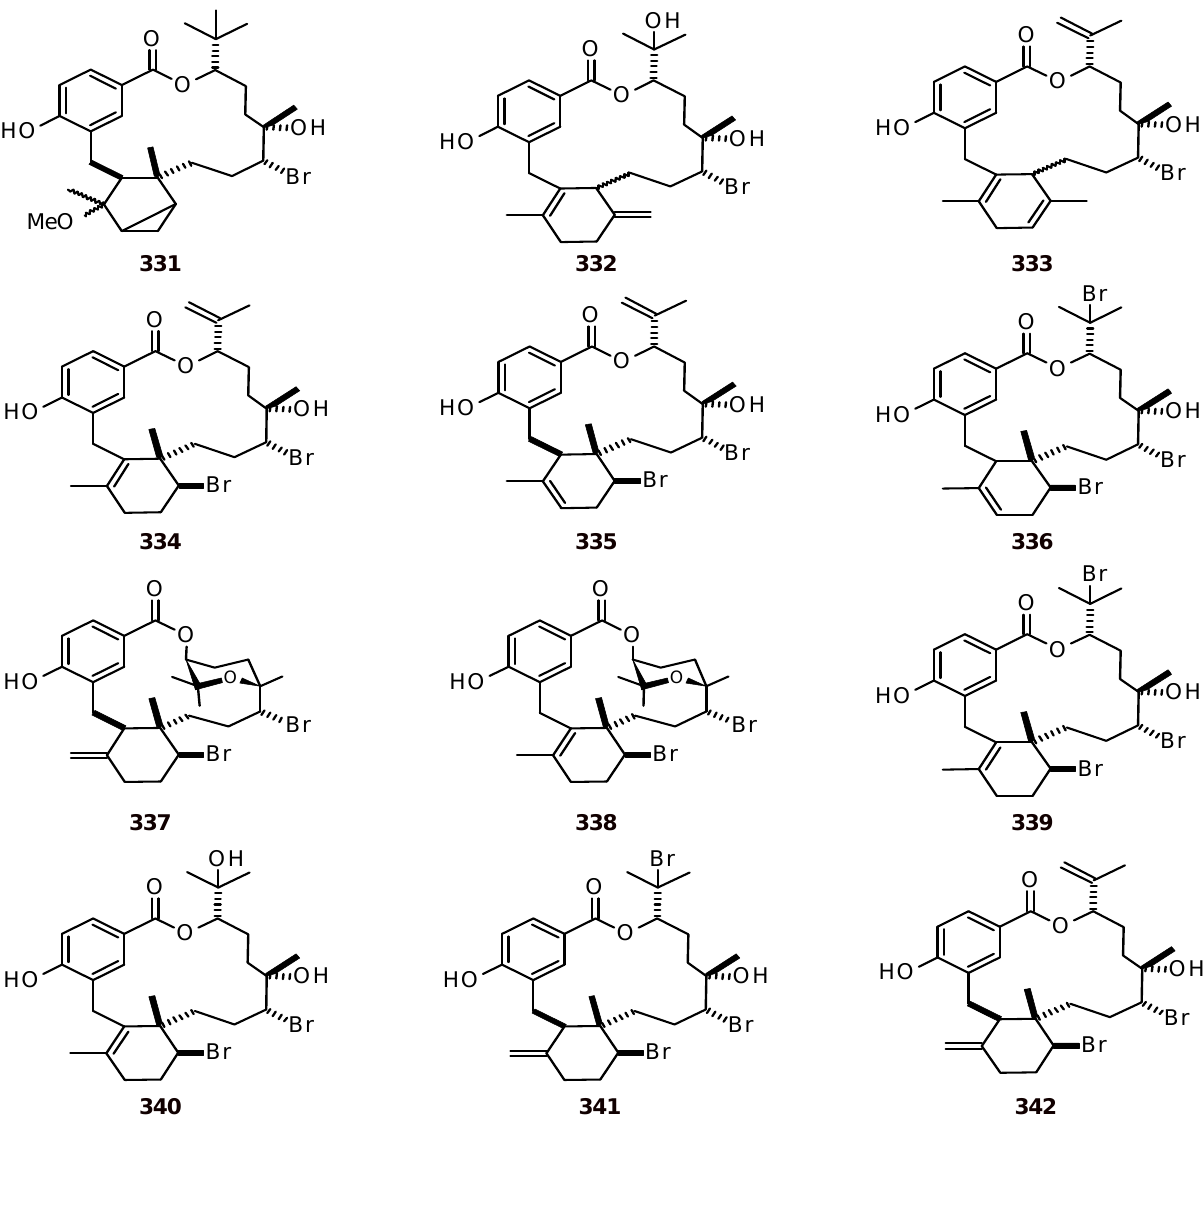
Figure 40. Structures of diterpene-benzoate macrolides and analogues 331 -